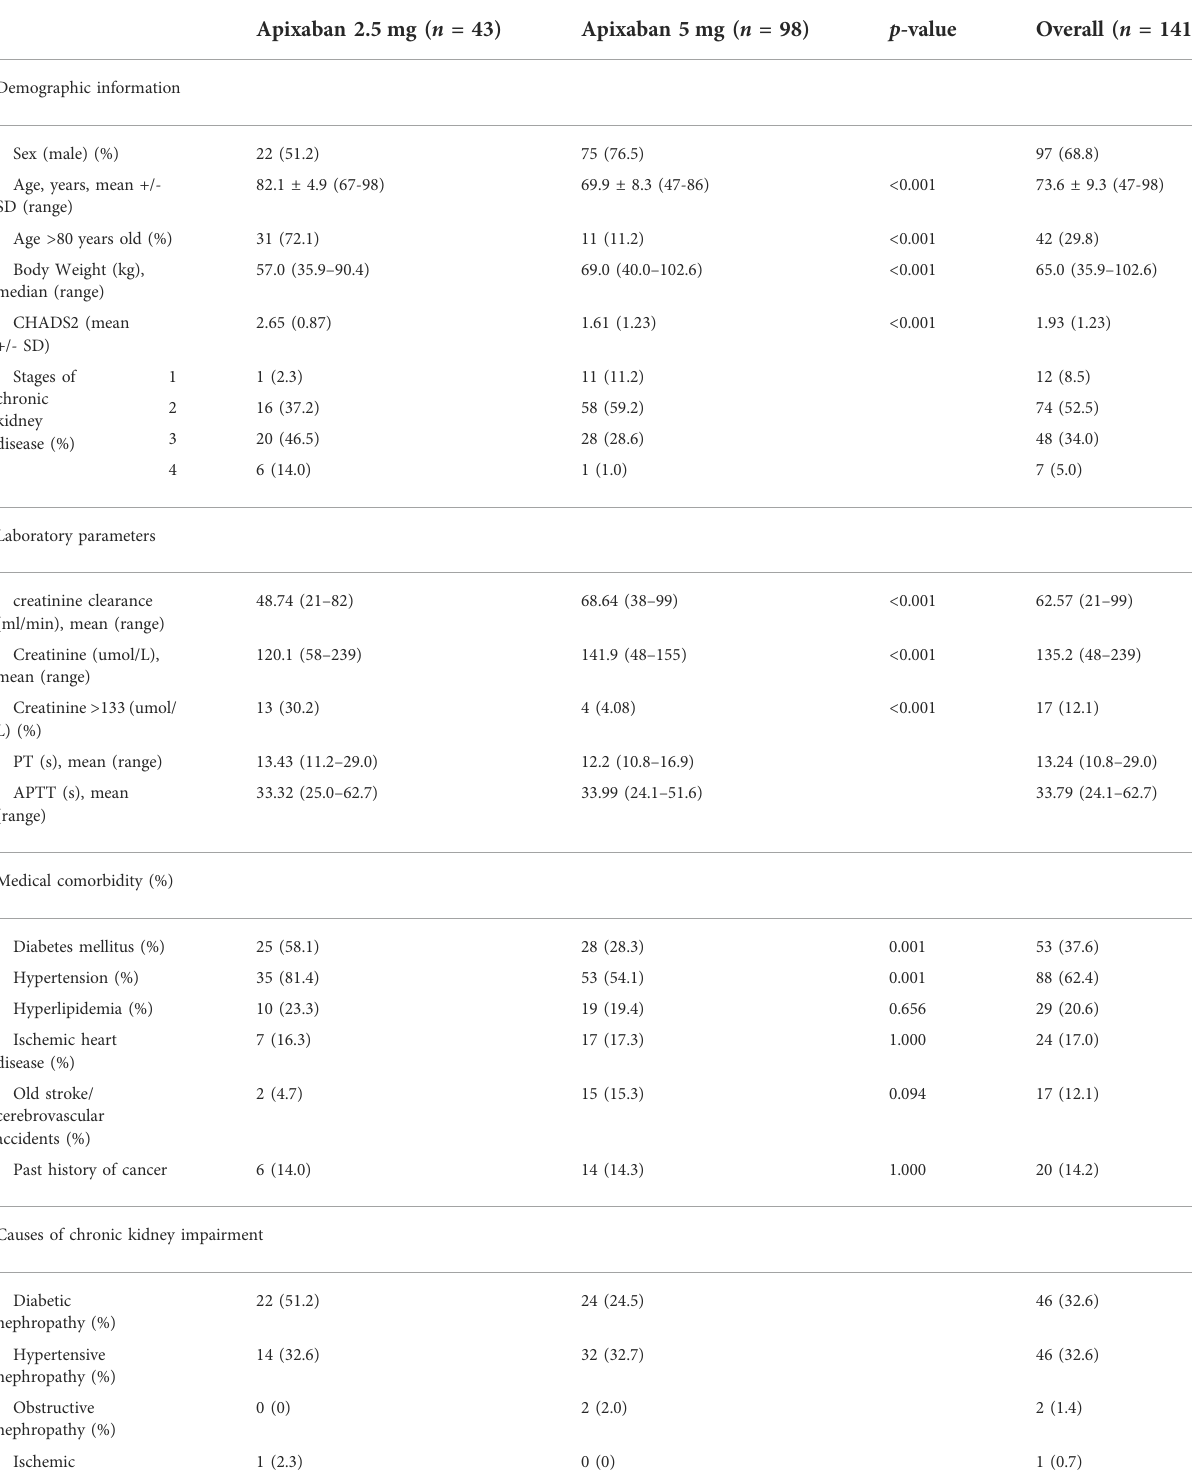
TABLE 1 Baseline characteristics of patients receiving apixaban 2.5 mg and 5 mg